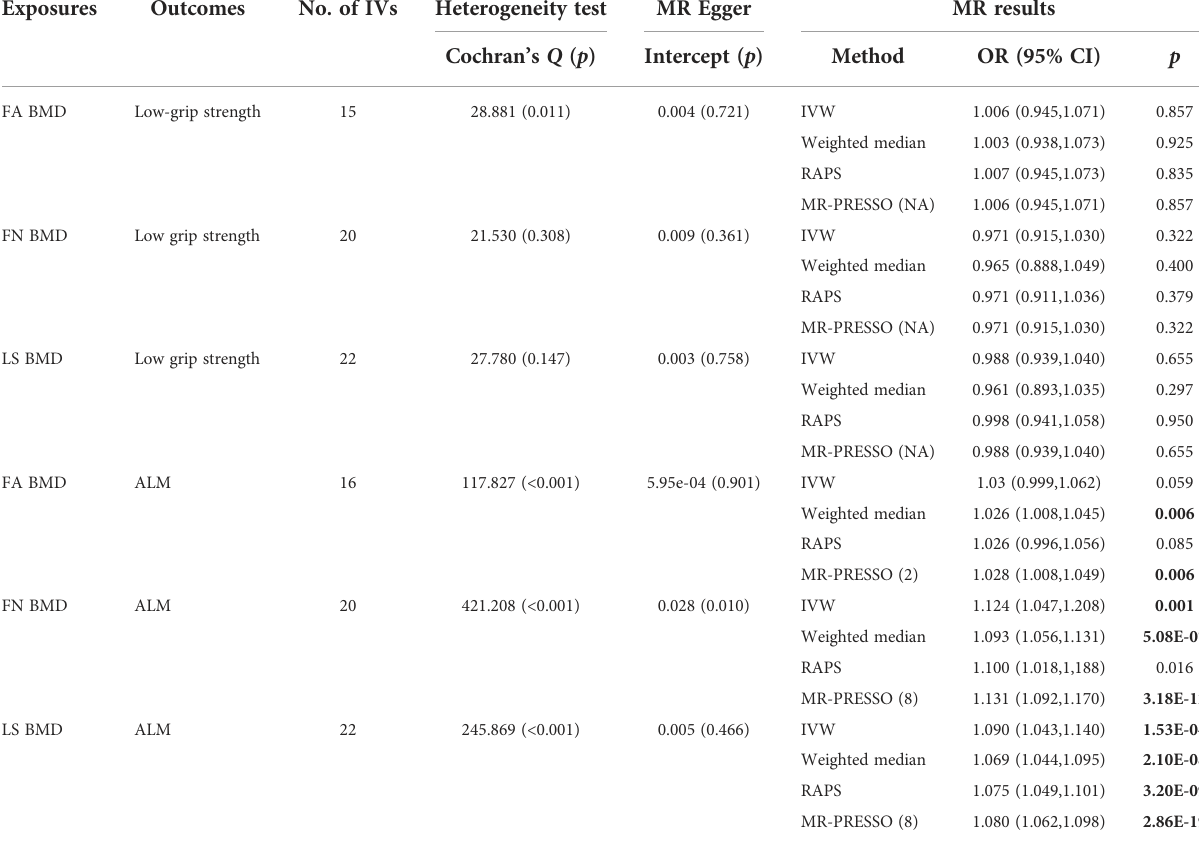
TABLE 1 Mendelian randomization estimates for BMD on sarcopenia-related traits with all selected IVs.